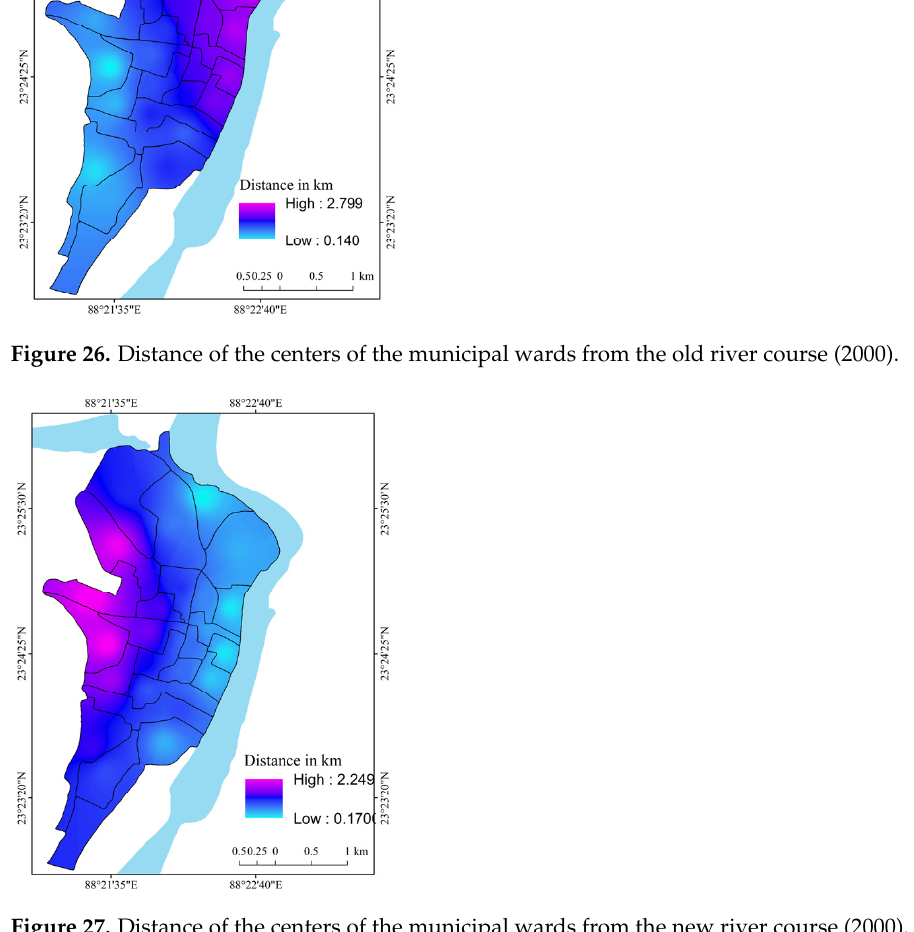
Figure 27. Distance of the centers of the municipal wards from the new river course (2000).